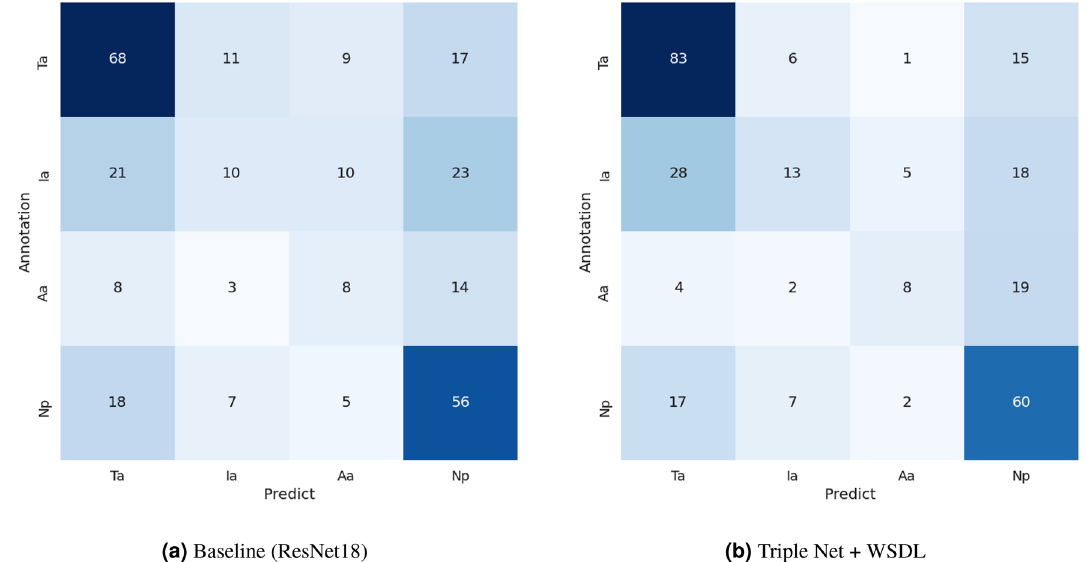
Figure 5. Evaluation results with confusion matrix using four-class classification. The left column presents the result of the baseline, while the right column shows the result of the Triple Net + WSDL. In the confusion matrix, Ta is the typical appearance, Ia is the indeterminate appearance, Aa is the atypical appearance and Np is the negative for pneumonia